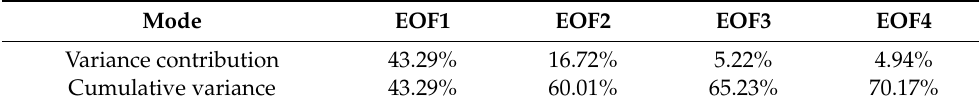
Table 1. The first four EOF of the variance contribution and cumulative variance (unit: %).